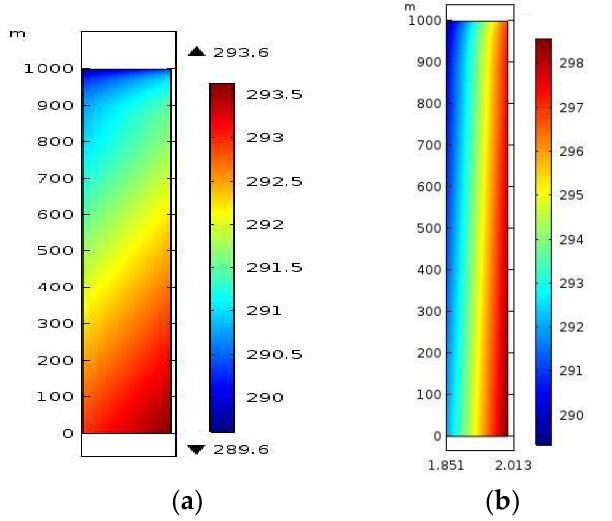
Figure 9. Nephograms of the internal temperature field of support materials: ( a ) Nephogram of the internal temperature field of the common sprayed concretes; ( b ) Nephogram of the internal temperature field of the heat-insulating materials doped with basalt